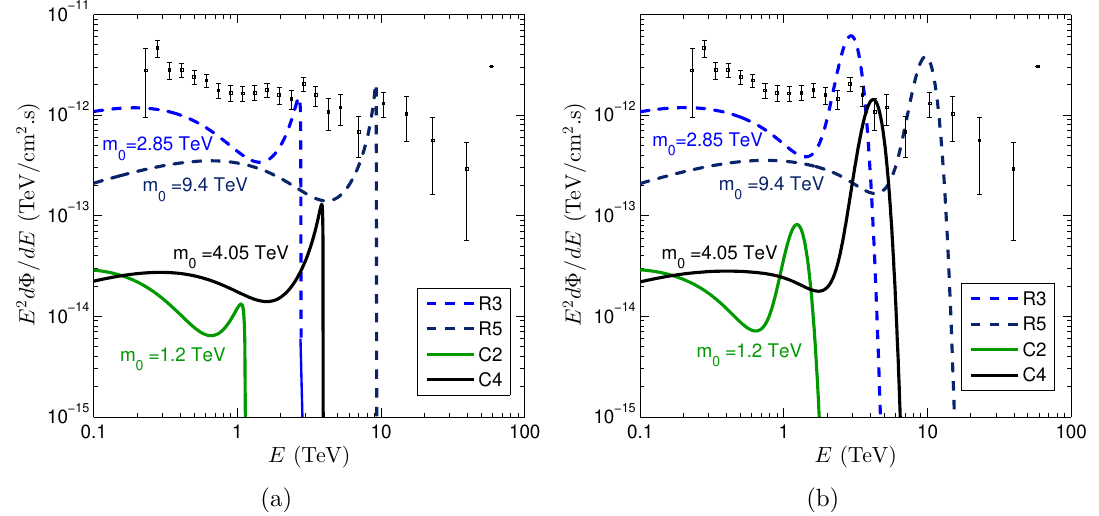
Figure 8. Left 8(a): the differential gamma-ray flux for four fermionic multiplets of EWDM namely real triplet (R3) in blue dashed line, real quintet (R5) in navy dashed, complex doublet (C2) in green solid, and complex quartet (C4) in black solid,; based on their freeze-out masses respectively 2.85 TeV, 9.4 TeV, 1.2 TeV, and 4.05 TeV with corresponding annihilation cross-section of 1 . 3 × 10 − 24 cm 3 /s, 1 . 65 × 10 − 24 cm 3 /s, 1 . 25 × 10 − 26 cm 3 /s, and 2 . 2 × 10 − 25 cm 3 /s. The measurement data by HESS collaboration and relevant error-bars [94] are also plotted. Right 8(b): the same spectra as in left panel, seen by a detector with resolution of